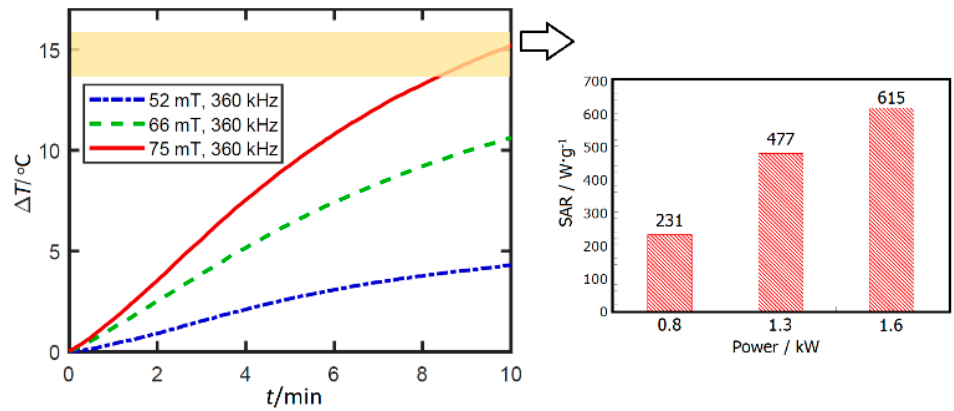
Figure 9. Temperature increase during 10 min of magnetic heating of ZnFe 2 O 4 nanorods in water at iron ions (Fe 3+ ) concentration of c = 0.56 mg · cm − 3 and SAR value.